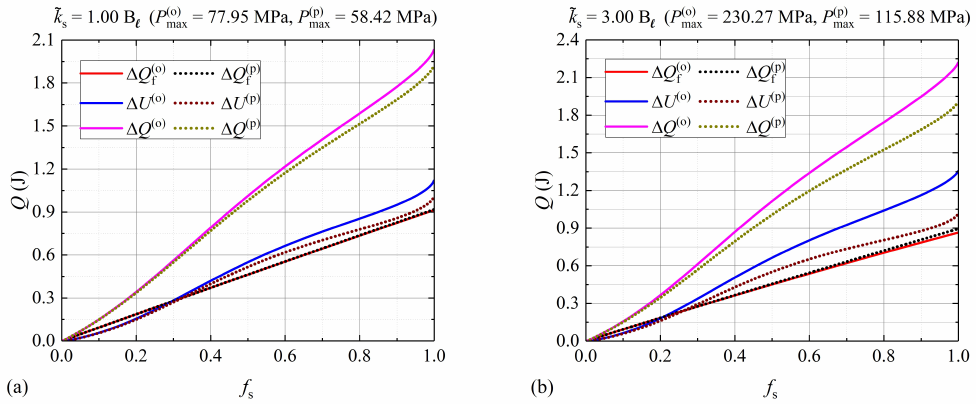
Figure 6. ( a ) ˜ k s = 1.00 B (cid:96) and ( b ) ˜ k s = 3.00 B (cid:96) . Sensible heat ( ∆ U ), latent heat ( ∆ Q f ), and total energy ( ∆ Q ) absorbed by the nitrate salt for each value of ˜ k s shown in this figure.